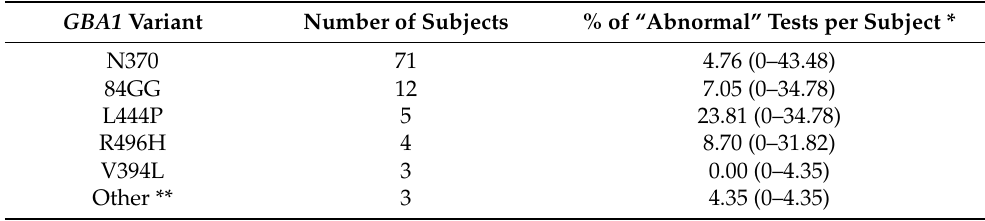
Table 4. Percentage of “abnormal” tests according to GBA1